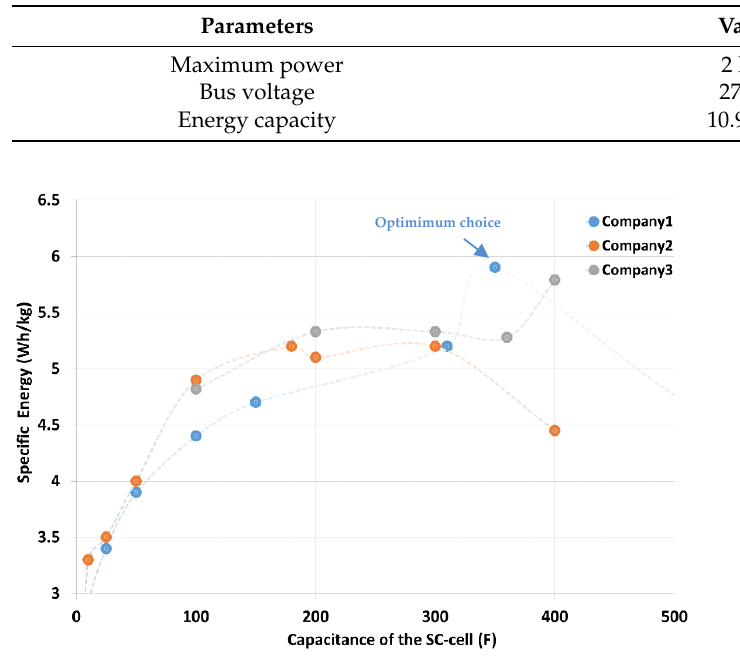
Figure 2. Comparing specific energy vs. nominal cell capacity for a range of SC cells .